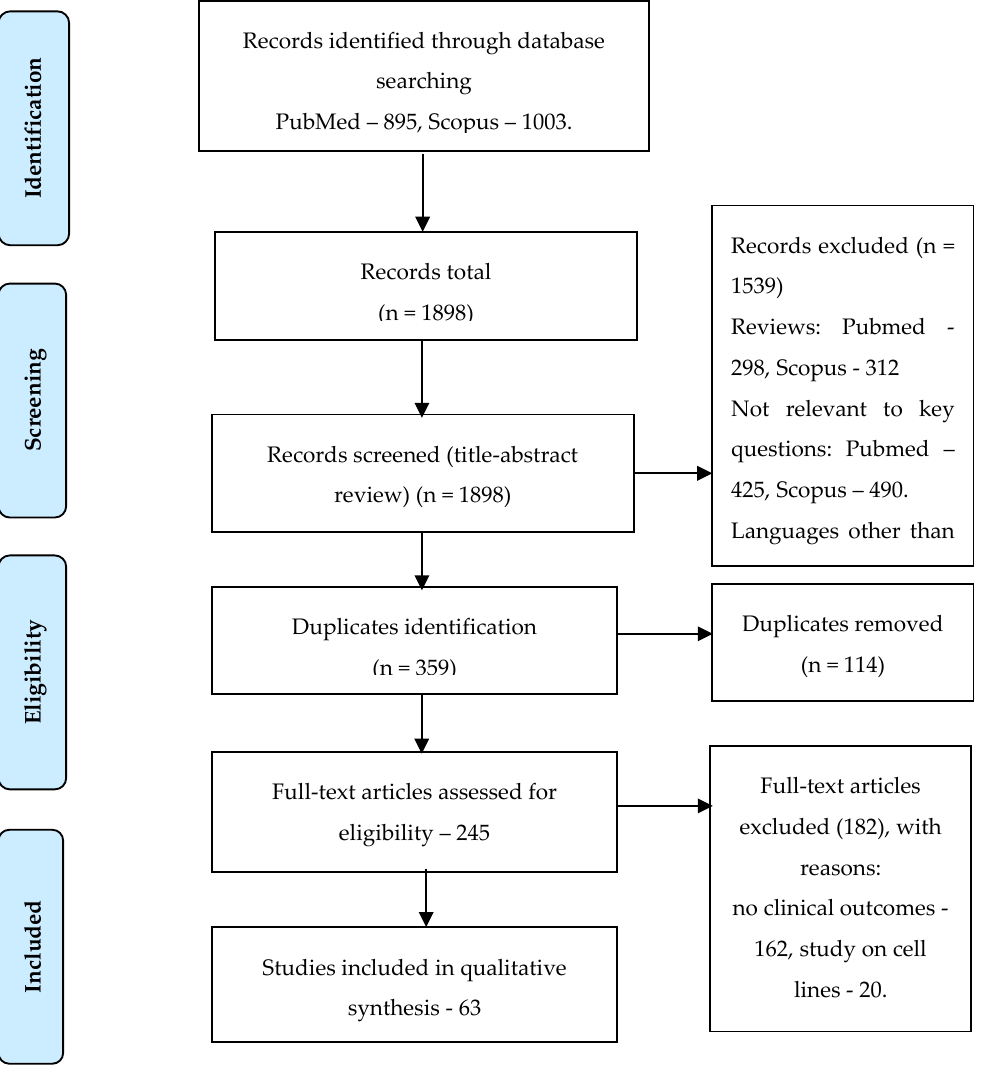
Figure 1. PRISMA statement.